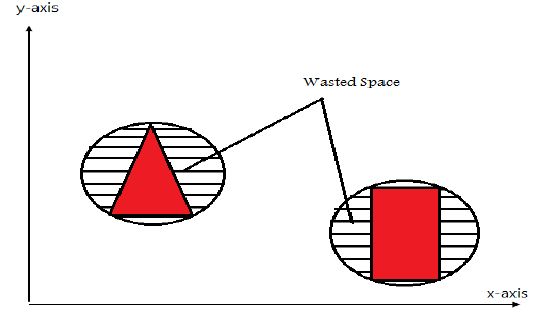
Fig. 5. Expanding the size of